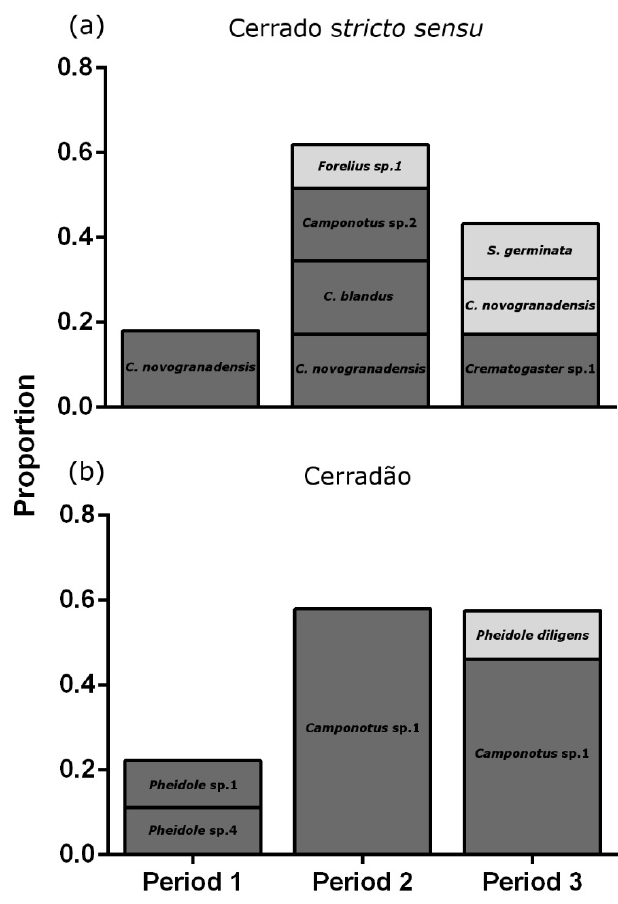
Fig 3 . The proportion of ant species found on food baits according to the cerrado area and observation period (period 1 = 8:00 to 10:00; period 2 = 12:00 to 14:00; period 3 = 16:00 to 18:00). Only the most frequent ant species – those that occupied at least 10% of all baits – were considered (see Material and Methods for details). In (a), Camponotus novogranadensis was found during all three periods of observation, being predominant during period 1. In (b), there was a smaller number of ant species, with the predominant ant, Camponotus sp. 1, being observed on more than 50% of baits during period 2 and 40% during period 3. Species in light gray boxes have a lower proportion when compared to the species below (dark gray). Species matching colors within the same bar have equal